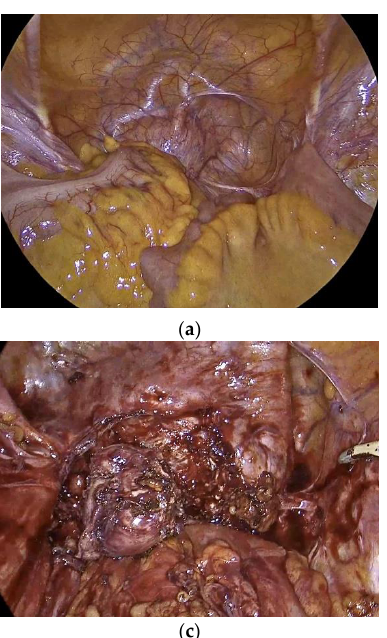
Figure 1. Pelvic MRI image with a lateral view showing multiple endometriomas around the cervical stump with extensive adhesions to the sigmoid colon.